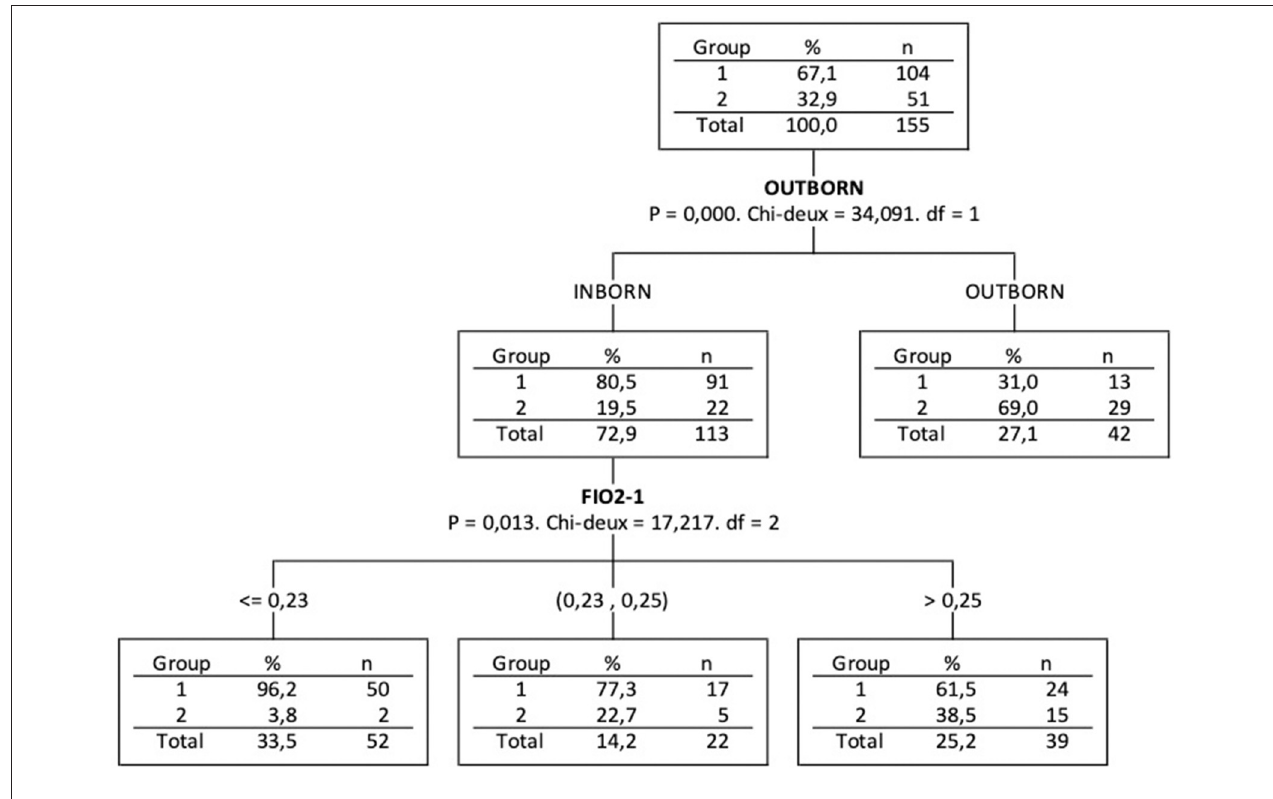
FIGURE 3 | Decision Tree by CHAID method.